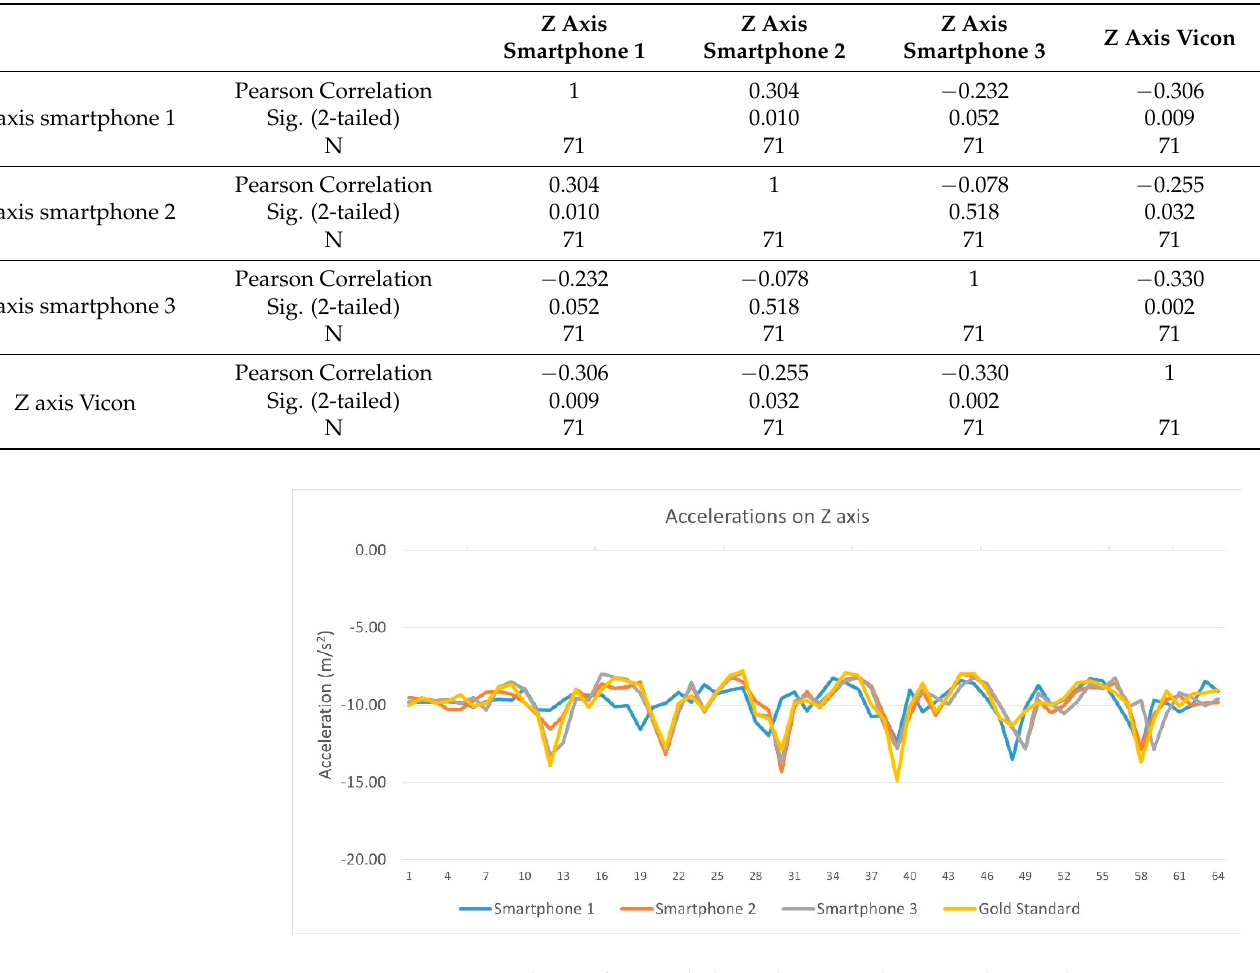
Figure 8. Pearson r correlations from each device linear acceleration’s data on the Z axis. Pertaining to the Intraclass Correlation Coefficient (ICC) of the acceleration magni- tude among the four devices used in this experiment, ICC values ranged from − 0.348 to 0.796. Specifically, acceleration magnitude ICC between (a) Smartphones 1 and Vicon system was − 0.348, sig = 0.008 (b) Smartphones2 and Vicon system was 0.796, sig = 0.001, (c) Smartphone 3 and Vicon system was 0.270, sig = 0.001 All ICC measures were statis- tically significant at p < 0.05. ICC values concerning acceleration magnitude of the four devices are illustrated in Table 6 and portrayed in Figure